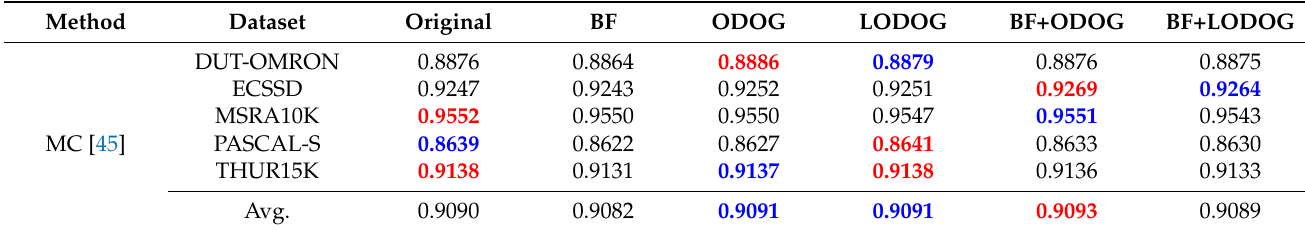
Table 3. AUC score comparison for each method used in the experiment. Red and blue indicate the best and second performances,